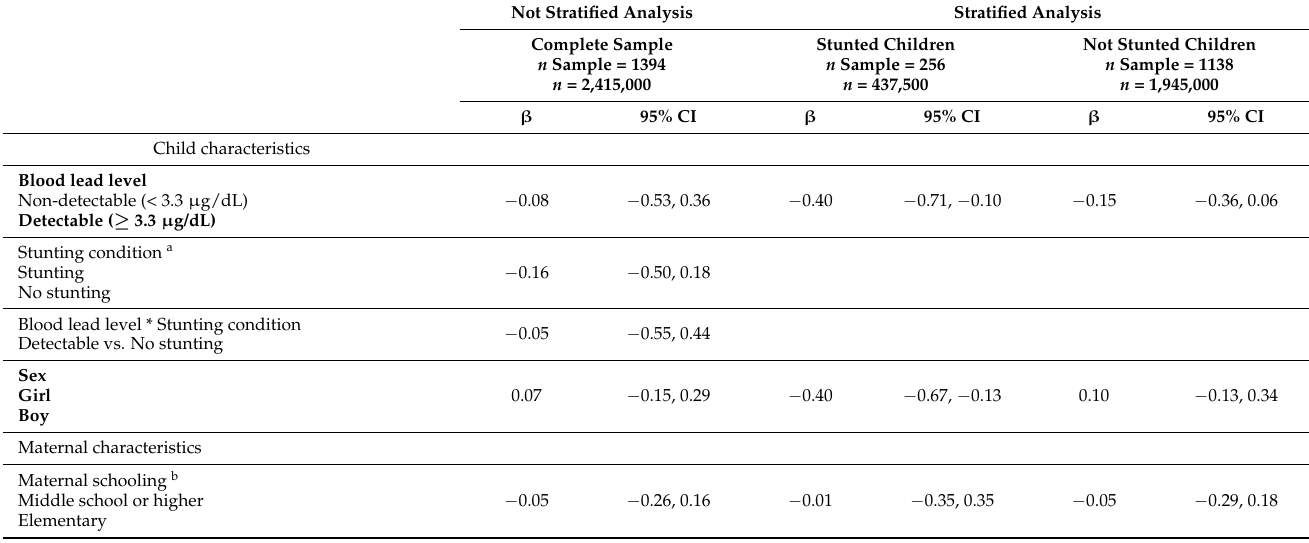
Table 3. Association between blood lead level and language z-score, stratified by stunting